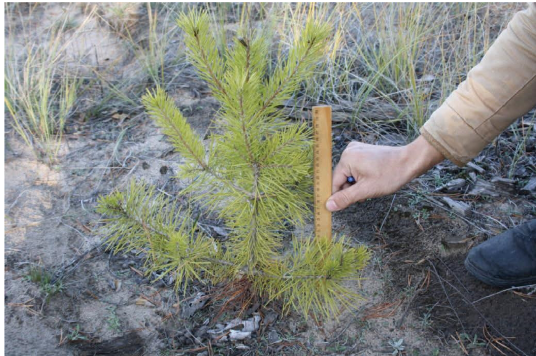
Figure 3: Photo of pine trees in plot 1 in the second year after planting.